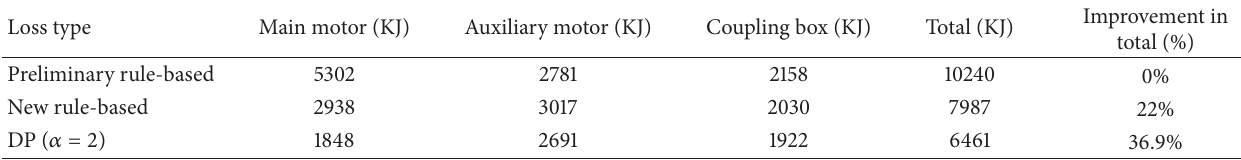
Table 2: Comparison of different control strategy in energy loss.